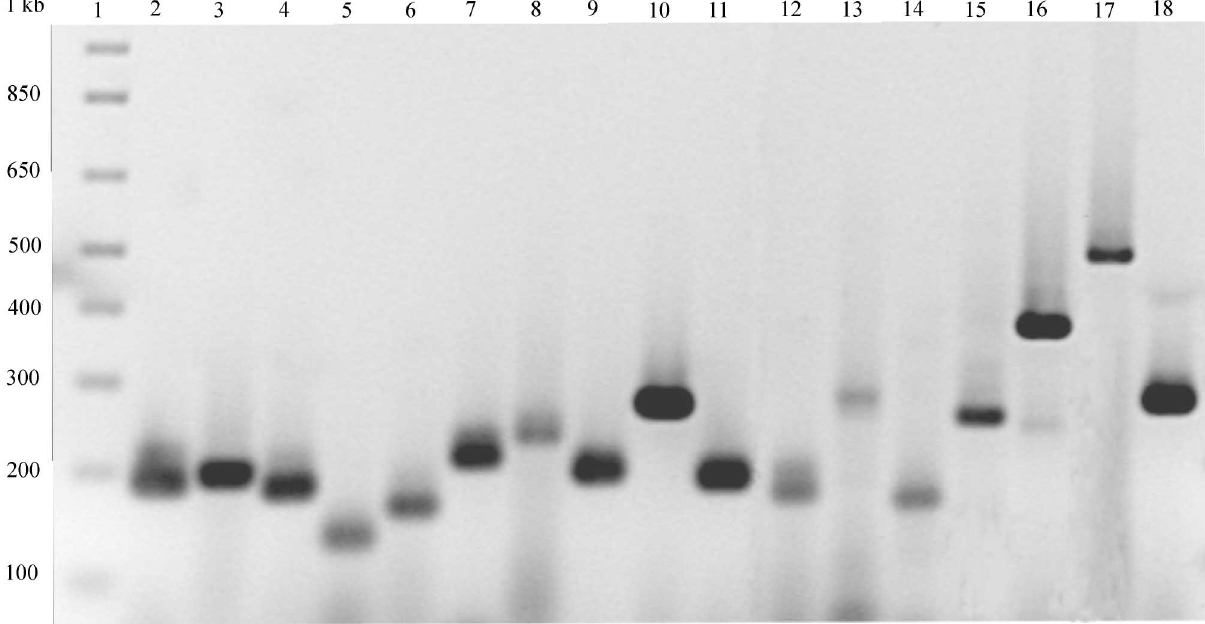
Figure 1 - PCR products amplified from common bean genomic DNA using primers indicated in Table 1. Lanes 2 to 18 correspond to products for 11M1, 12M1, 13M1, 14M1, 8M2, 129M2, 130M2, 133M2, 137M2, 149M2, 59M3, 71M3, 118M3, 143M3, 195M3, 228M3, and PVMADS, respectively. Lane 1 shows the “1 kb” ladder (GIBCO-BRL) size